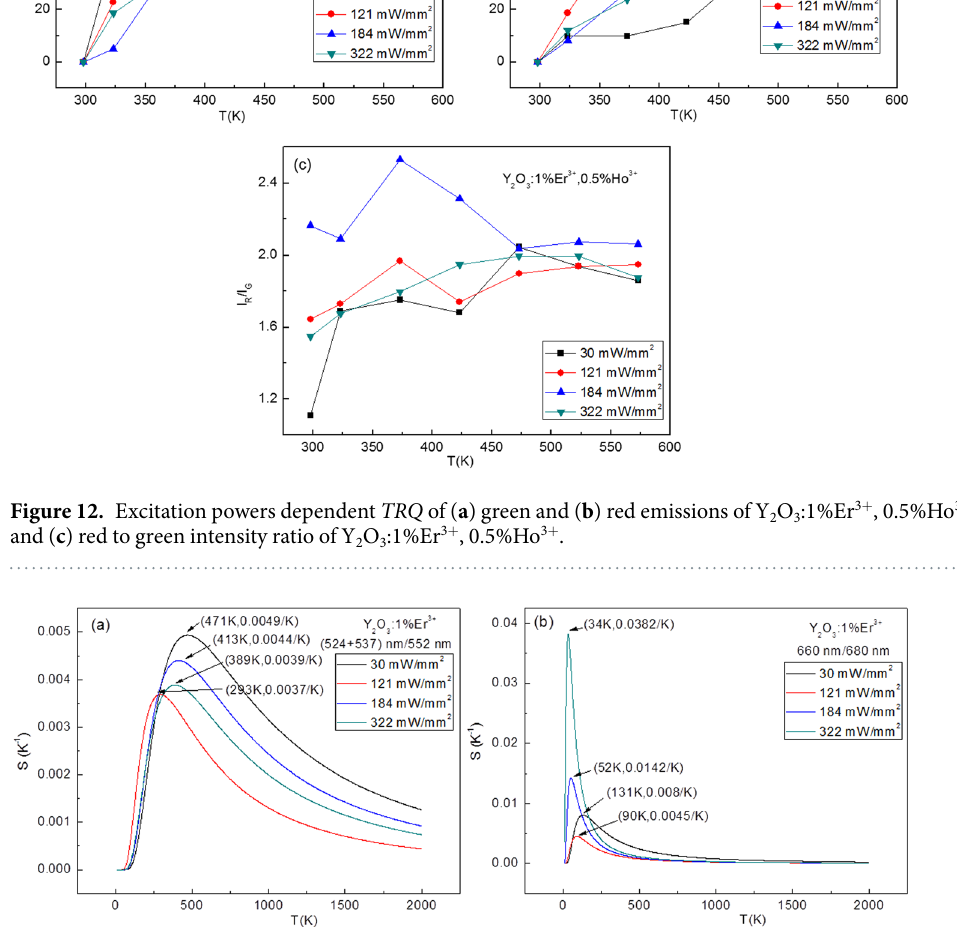
and the sensitivity value based on 4 F 9/2(1) / 4 F 9/2(2) thermal coupled levels reaches the maximum value at 121 mW/ mm 2 , as shown in Fig. 16(d).